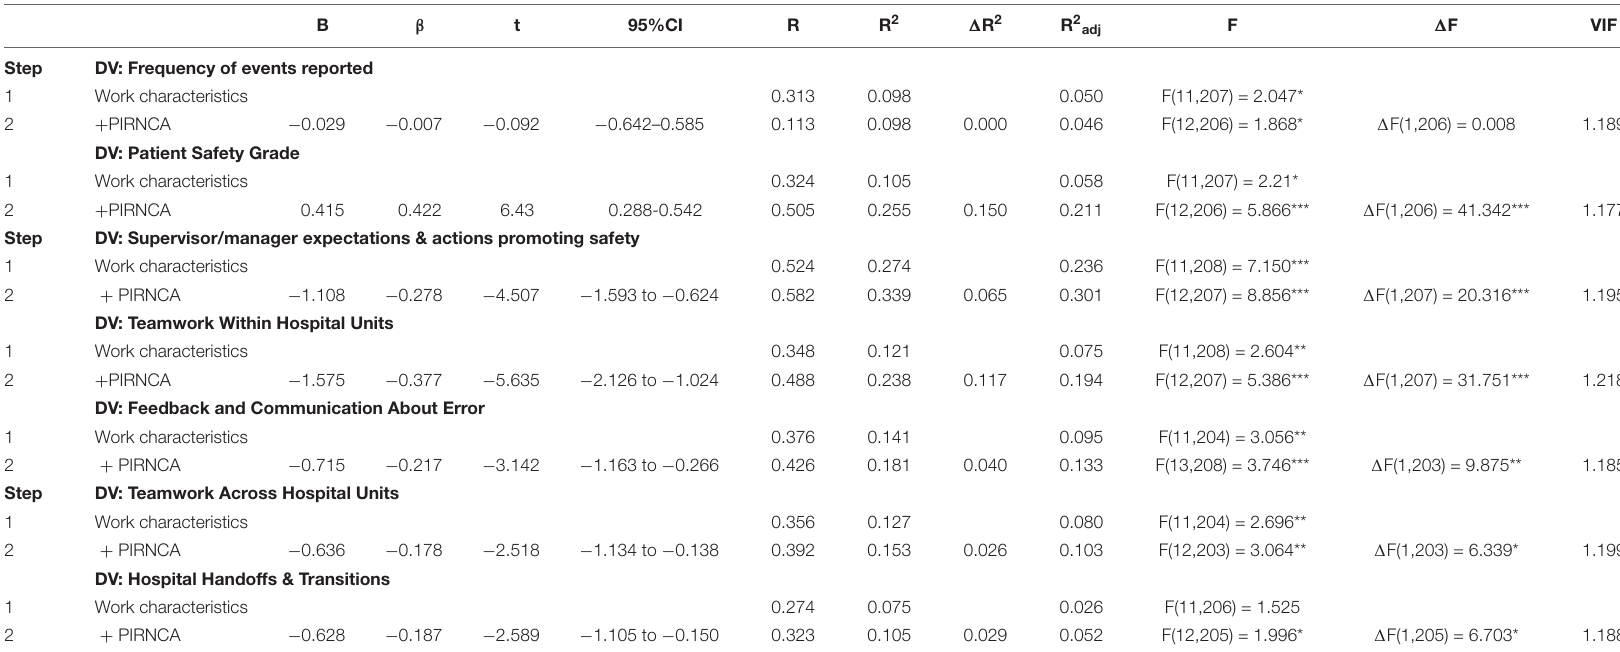
TABLE 4 | Summary of Hierarchical Regression Analysis for perceived implicit rationing of nursing care (PIRNCA) associated with outcome measures of Patient Safety Culture, Safety Culture Dimensions (Unit level), and Safety Culture Dimensions